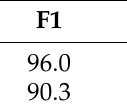
Table 4. The EPO performance of T RN and TPLinker on the WebNLG test set.